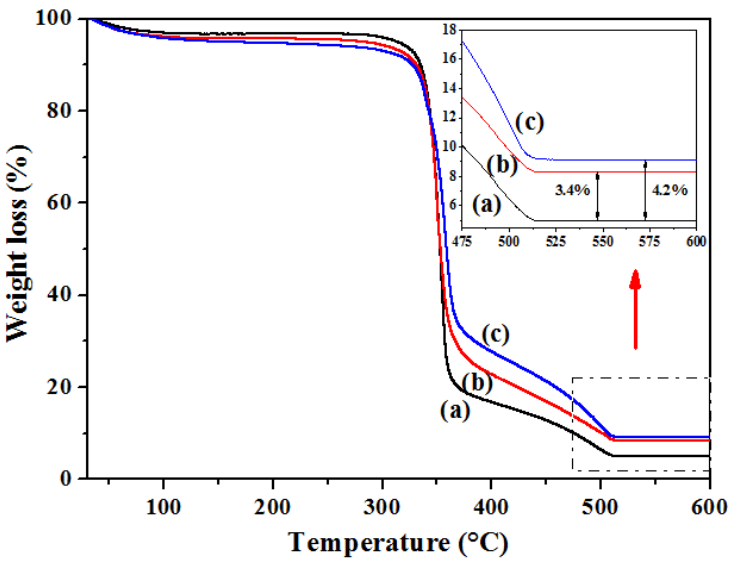
Figure 6. Thermogravimetric analysis curves of neat paper ( a ), paper–TiO 2 ( b ) and paper–TiO 2 –AgBr ( c ).